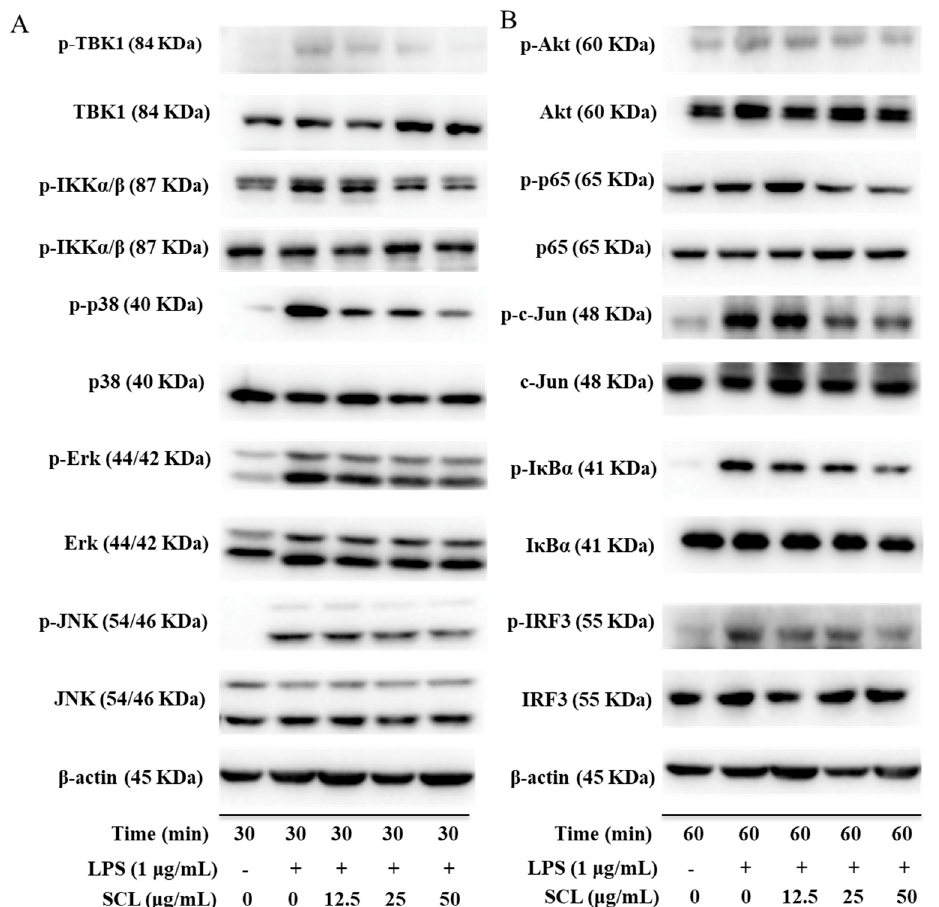
Figure 5. SCL affects the components of IKK α / β /NF- κ B, MAPKs/AP-1 and TBK1/IRF3 pathways in LPS-stimulated RAW264.7 cells. Cells were treated with SCL at the indicated concentrations for 1 h and then stimulated with LPS for 30 min or 60 min. Total and phosphorylated forms of corresponding proteins were detected by Western blotting ( A and B ).